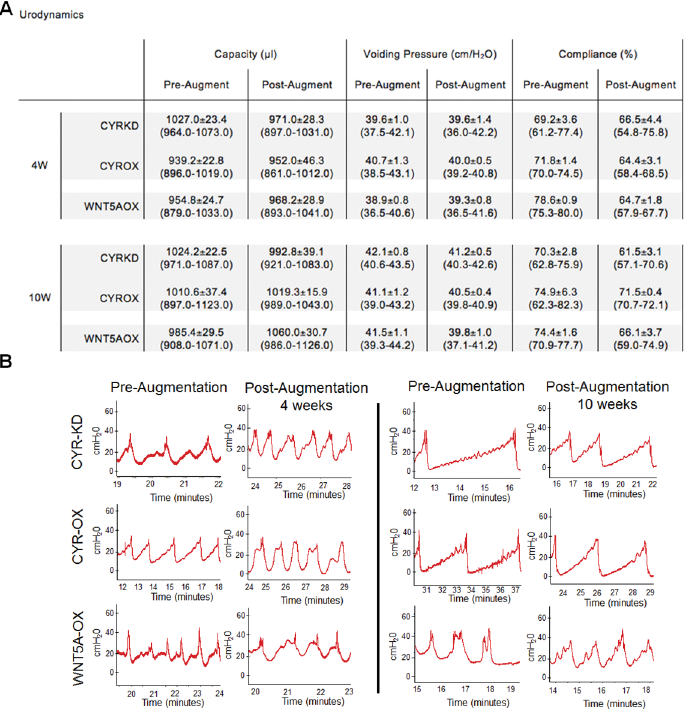
Fig 5. Effects of Cyr61 and Wnt5a on urodynamics. (A) Data shown as means ± SEM (range) for pre- and post-augment capacity (volume infused prior to first urine leak), voiding pressure (highest pressure at time of void) and compliance (percentage of bladder volume infused at pressures (cid:1) 20 cmH 2 O). By 4 weeks, Cyr61KD, Cyr61OX and Wnt5aOX groups all demonstrated > 90% mean percent recovery of pre-augment bladder capacity [(post-augment capacity – pre-augment capacity) * 100]. (B) Representative tracings from urodynamics evaluation. Voiding pressures averaged 40 cm H 2